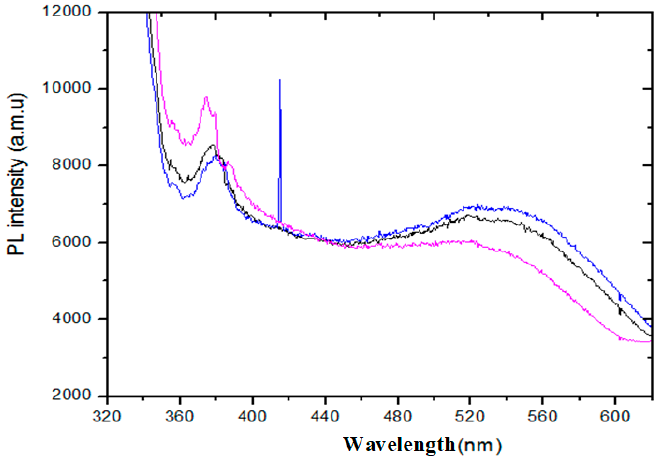
Figure 6. Photoluminescence spectra of doped Co 1-x Ni x Cr 2 O 4 .